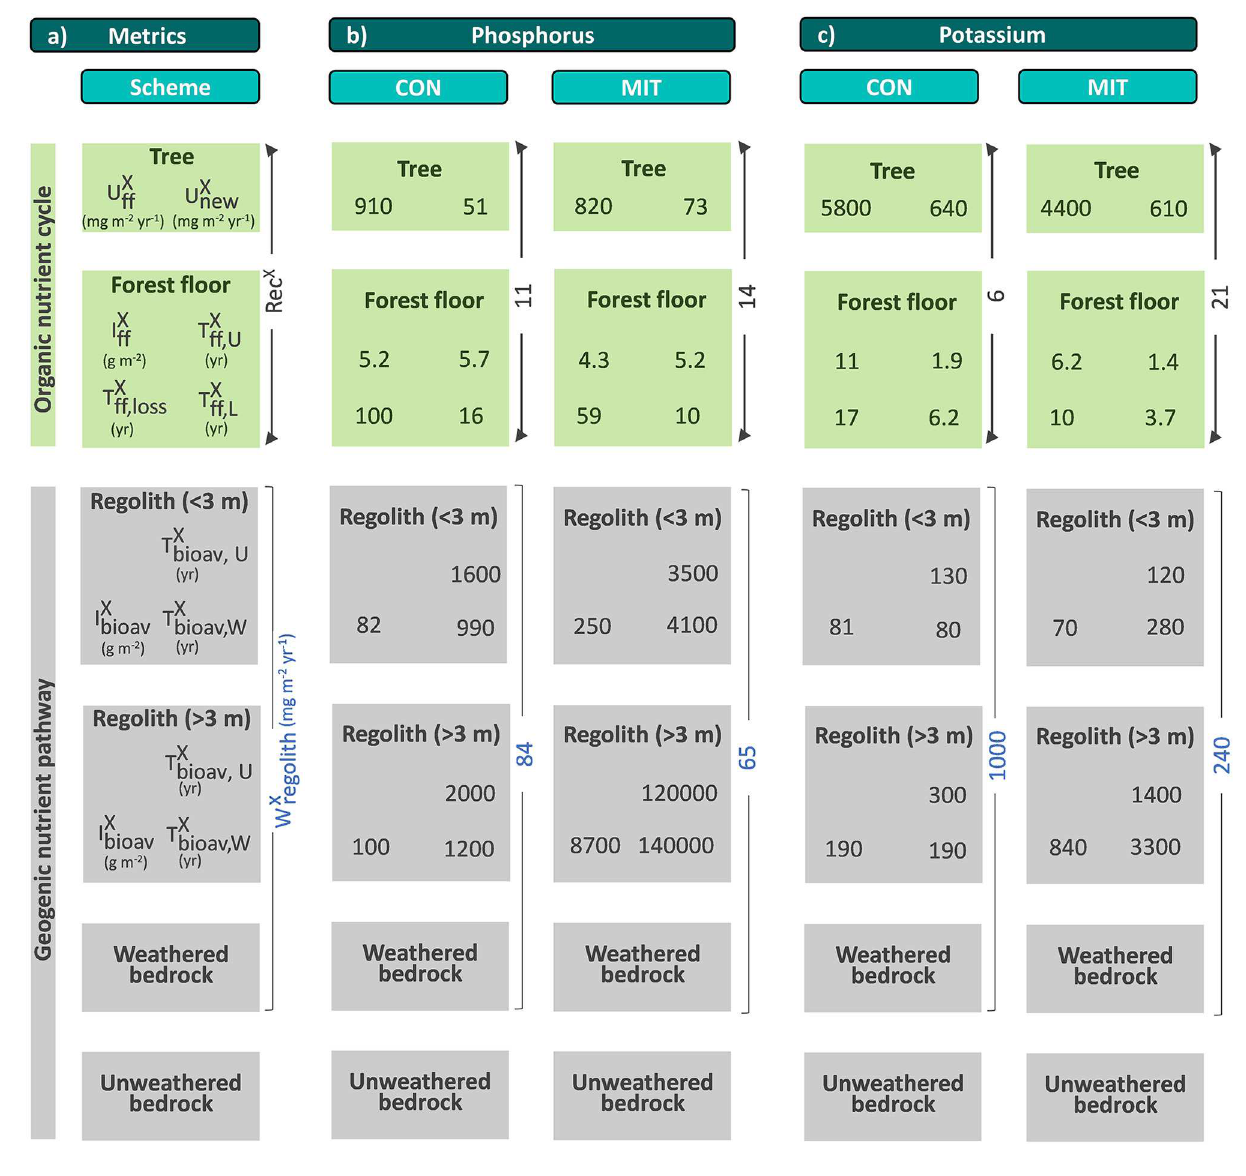
FIGURE 10 | Fluxes ( U X new , U X ff , W X regolith ), inventories ( I X ff , I X bioav ), turnover times ( T X ff , loss , T X ff , U , T X ff , L , T X bioav , W , T X bioav , U ), and recycling factors ( Rec X ) of nutrients in